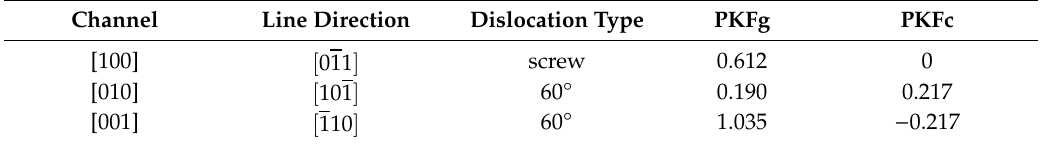
Table 7. Normalized Peach Köhler glide (PKFg) and climb forces (PKFc) for dislocation family 2 (red dislocation in Figure 9, Burgers vector: 1 / 2 [ 011 ] ) in the three types of γ